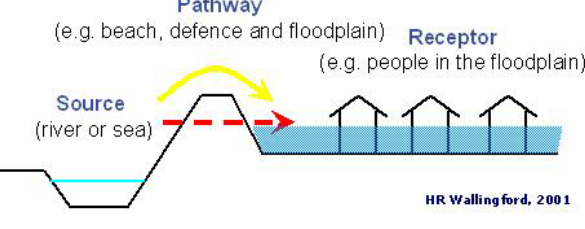
Fig. 1. The Source-Pathway-Receptor (SPR) model in flooding analysis (H R Wallingford, 2002, obtained from www.floodsite.net, © H R Wallingford,